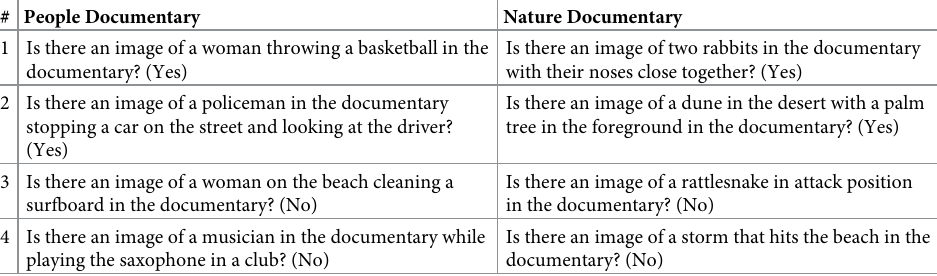
Table 1. Example of questions related to the documentary content administered to participants right after the end of the video (memory